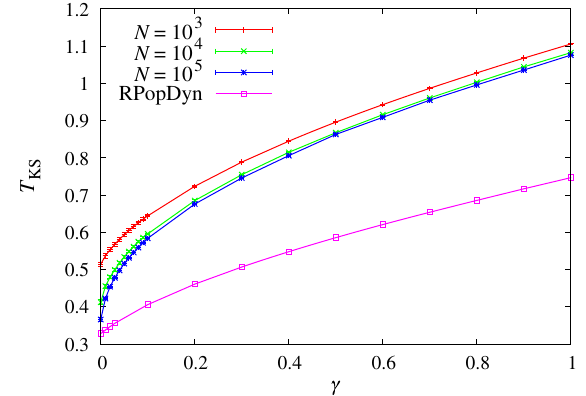
y ¼ 64 ; γ Þ at c ¼ 17 as a function of the coupling FIG. 15. T KS ð γ among replicas. The upper curves are obtained running RBP on several graph of a given size N , while the lower curve is obtained running population dynamics to solve Eqs. (D2), or equivalently, computing the largest eigenvalue of matrix in Eq. (D6). The limit N → ∞ of the former computation coincides with the latter only at γ ¼ 0 . As soon as γ > 0 , the assumption of the replicated graph being locally treelike is wrong, and the latter computation fails, while running RBP on a given graph still provides a reliable value for T KS